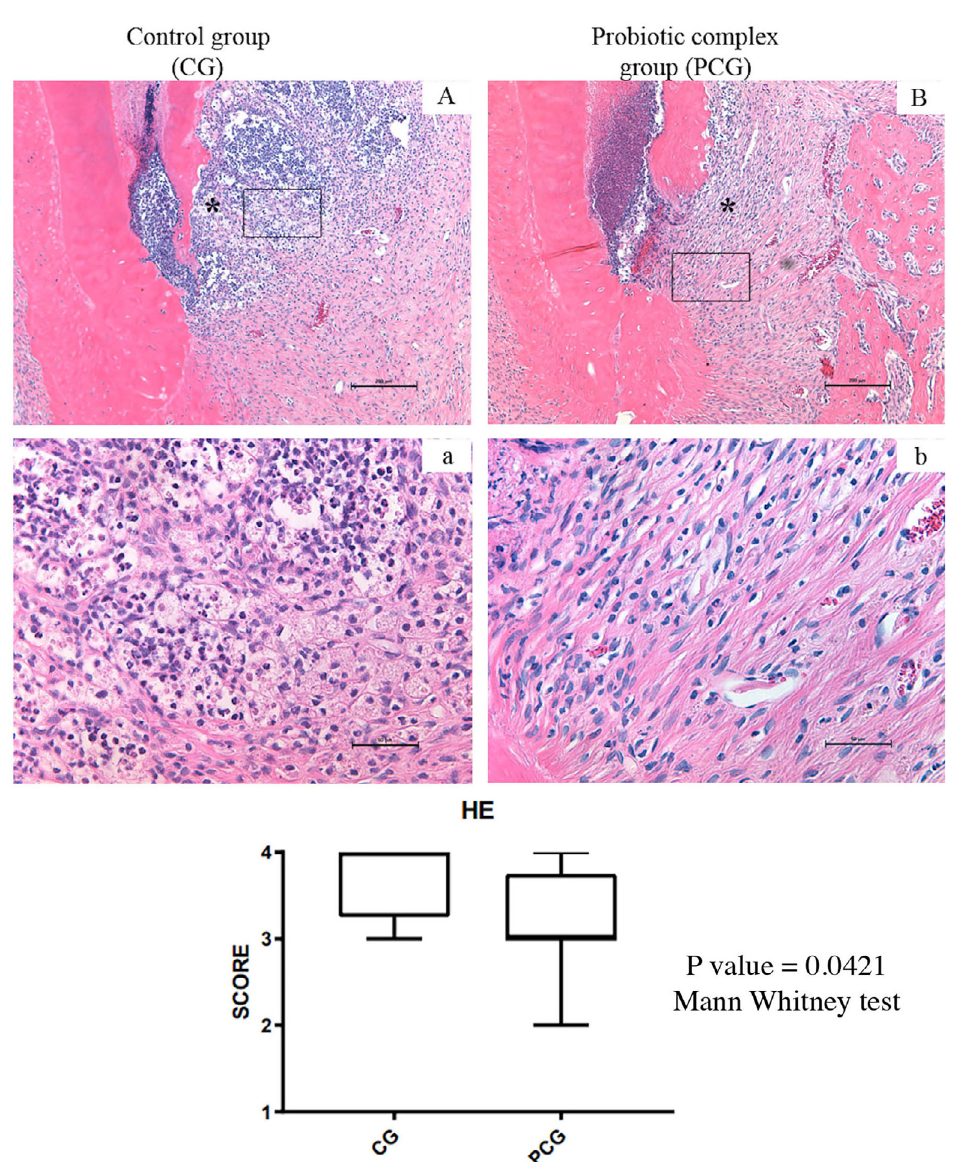
Figure 1- Representative photomicrographs showing histologic aspects of periapical regions (A-B, a-b). Control Group (n: 8) (A,a) showed more severe apical periodontitis than group that administered GNC Probiotic Complex (CODE424639) (n: 8). Haematoxylin–eosin staining. *Inflammatory infiltrate. Rectangle shows area elected for 400X magnification. Original magnification: A and B 100X; a and b 400X. Charts showing scores for inflammatory